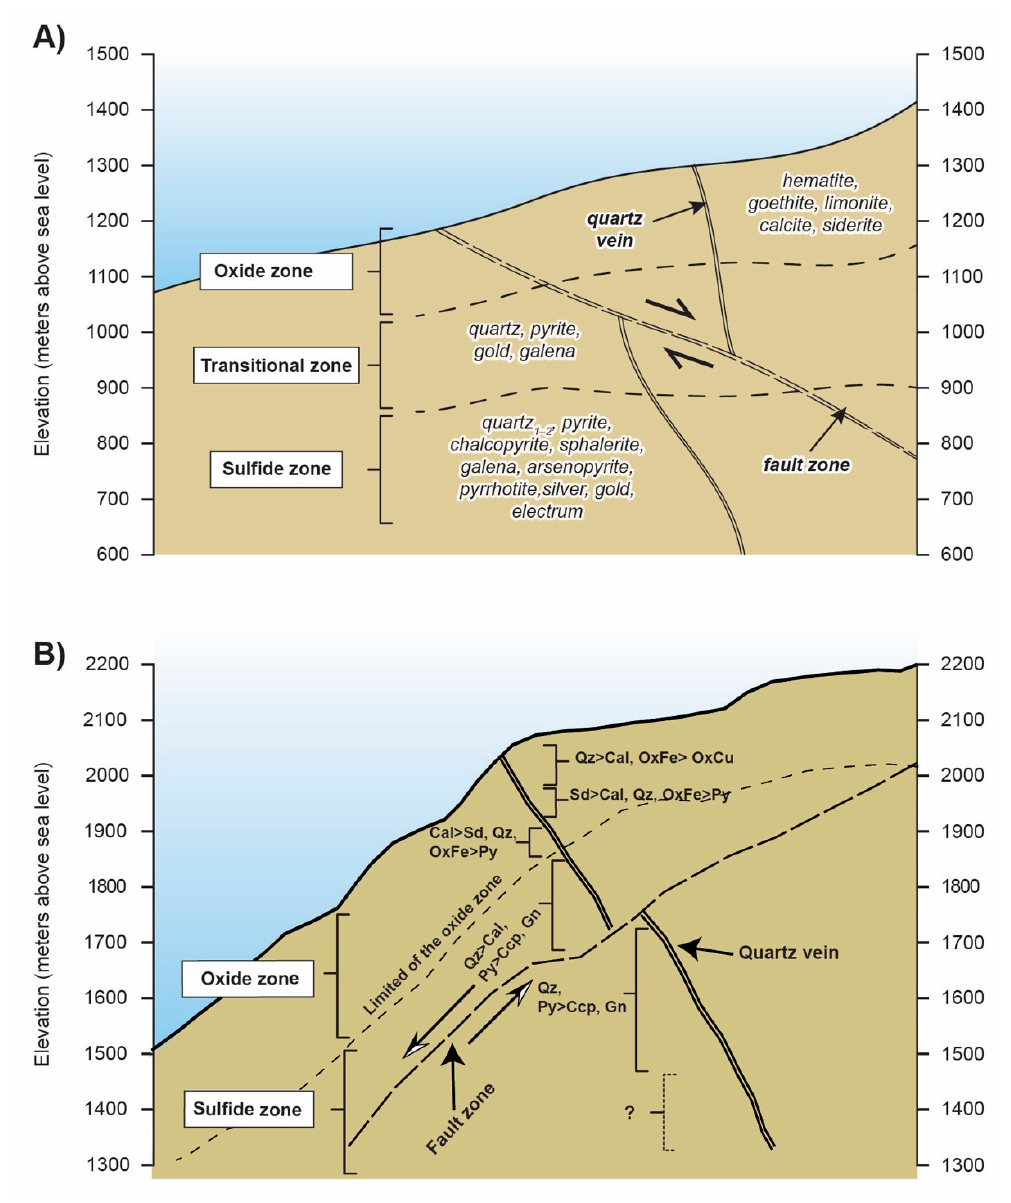
Figure 14. Cross section of mineralization zones. ( A ) San Juan de Chorunga sector (San Juan vein), ( B ) Mollehuaca sector (Virucha Capitana vein). Qz = quartz; Cal = calcite; OxFe = iron oxyhydroxides; OxCu = copper oxides; Sd = siderite; Py = pyrite; Gn = galena; Ccp = chalcopyrite.